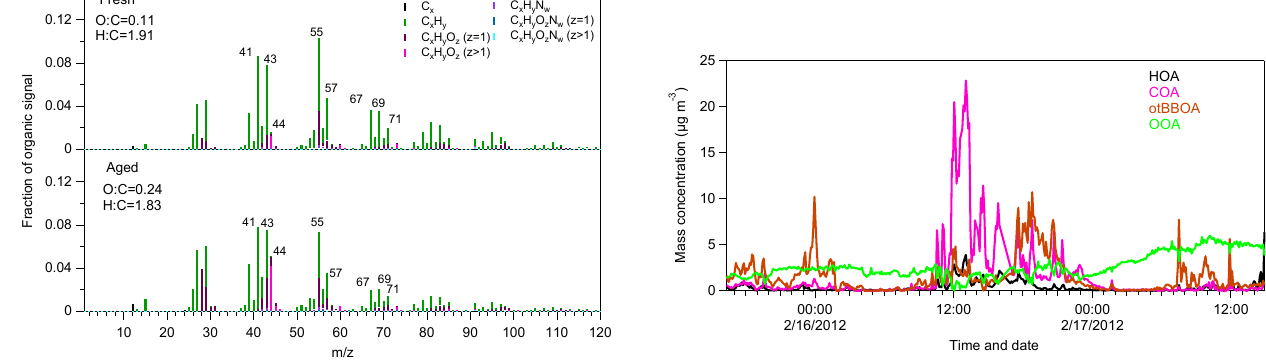
component particles was 0 . 76 ± 0 . 07. Applying HR-PMF analysis (using PET) on the AMS spectra for these 2 days of measurements, four sources were identified. PMF solu- tions up to five factors were examined and evaluated, while the tested f peak range was between − 2 and 2. More